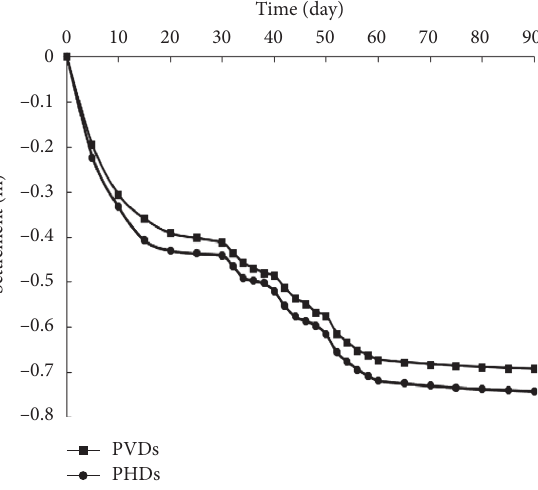
Figure 5: Central subsidence of surface and its relation